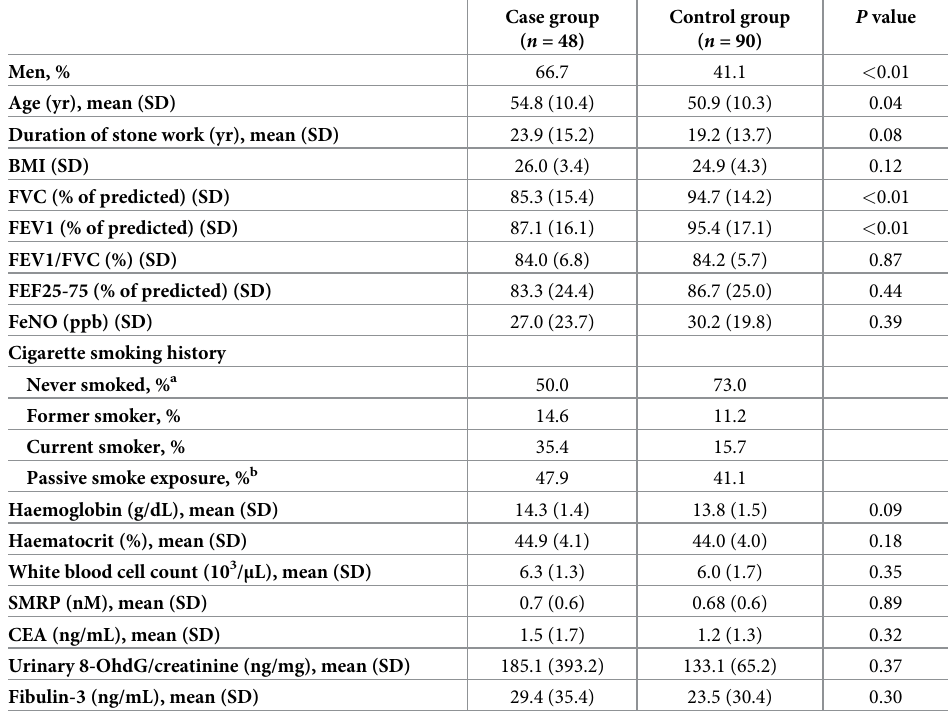
Table 1. Characteristics of the study